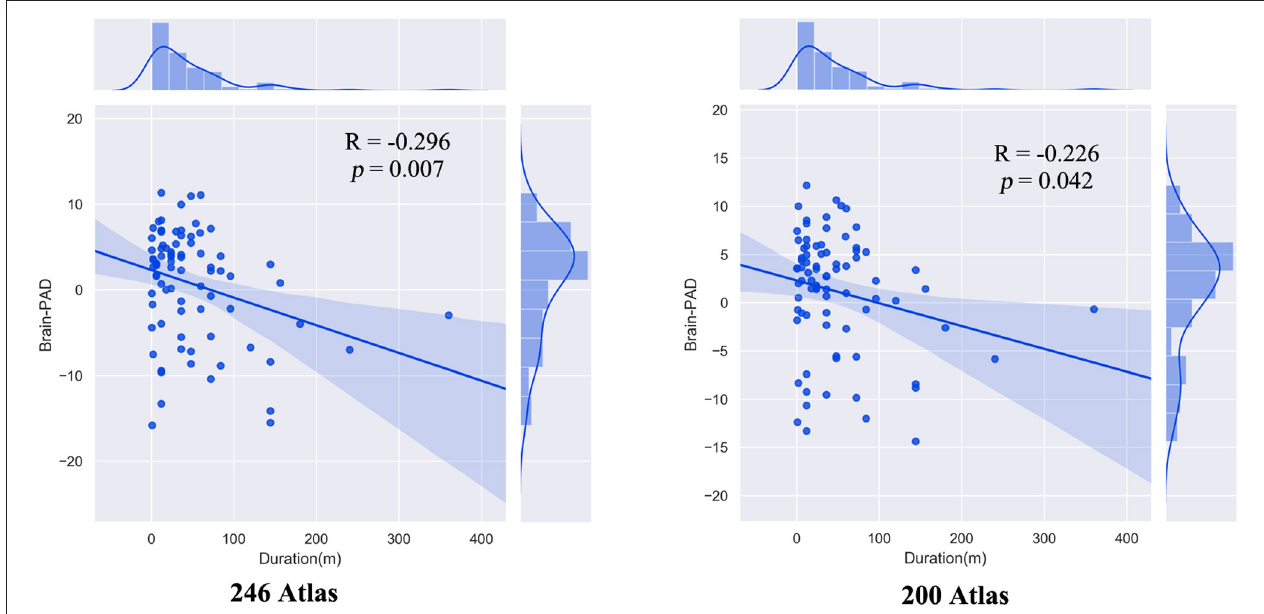
FIGURE 4 | The correlation between brain-PAD scores and illness duration (month) in patients with